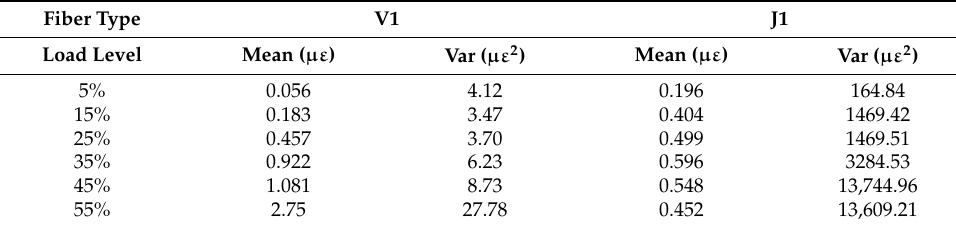
Figure 6. Strain at the left part of the bent cap under rising load: ( a ) Fiber V1; ( b ) Fiber J1. Table 1. Mean value and variance of strain increments from different optical fibers (με).